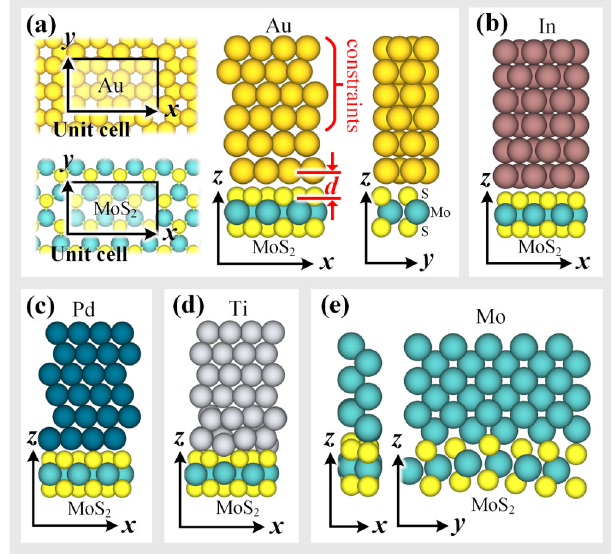
FIG. 8. Optimized geometries of top contacts to MoS 2 : (a) Au-MoS 2 (in different views), (b) In-MoS 2 , (c) Pd-MoS 2 , (d) Ti-MoS 2 , (e) Mo-MoS 2 (in different views). d is defined as the physical separation (the z component of the nearest core-to- core distance between the metal atoms and the chalcogenide , E , c v atoms). Radii of the atomic spheres shown in (a) – (e) are fixed to the covalent radius of the elements, which is a measure of the size of an atom that forms part of one covalent bond. Hence, the touching of atomic spheres indicates the formation of covalent bonds [e.g., the Ti-S bond in (d)].